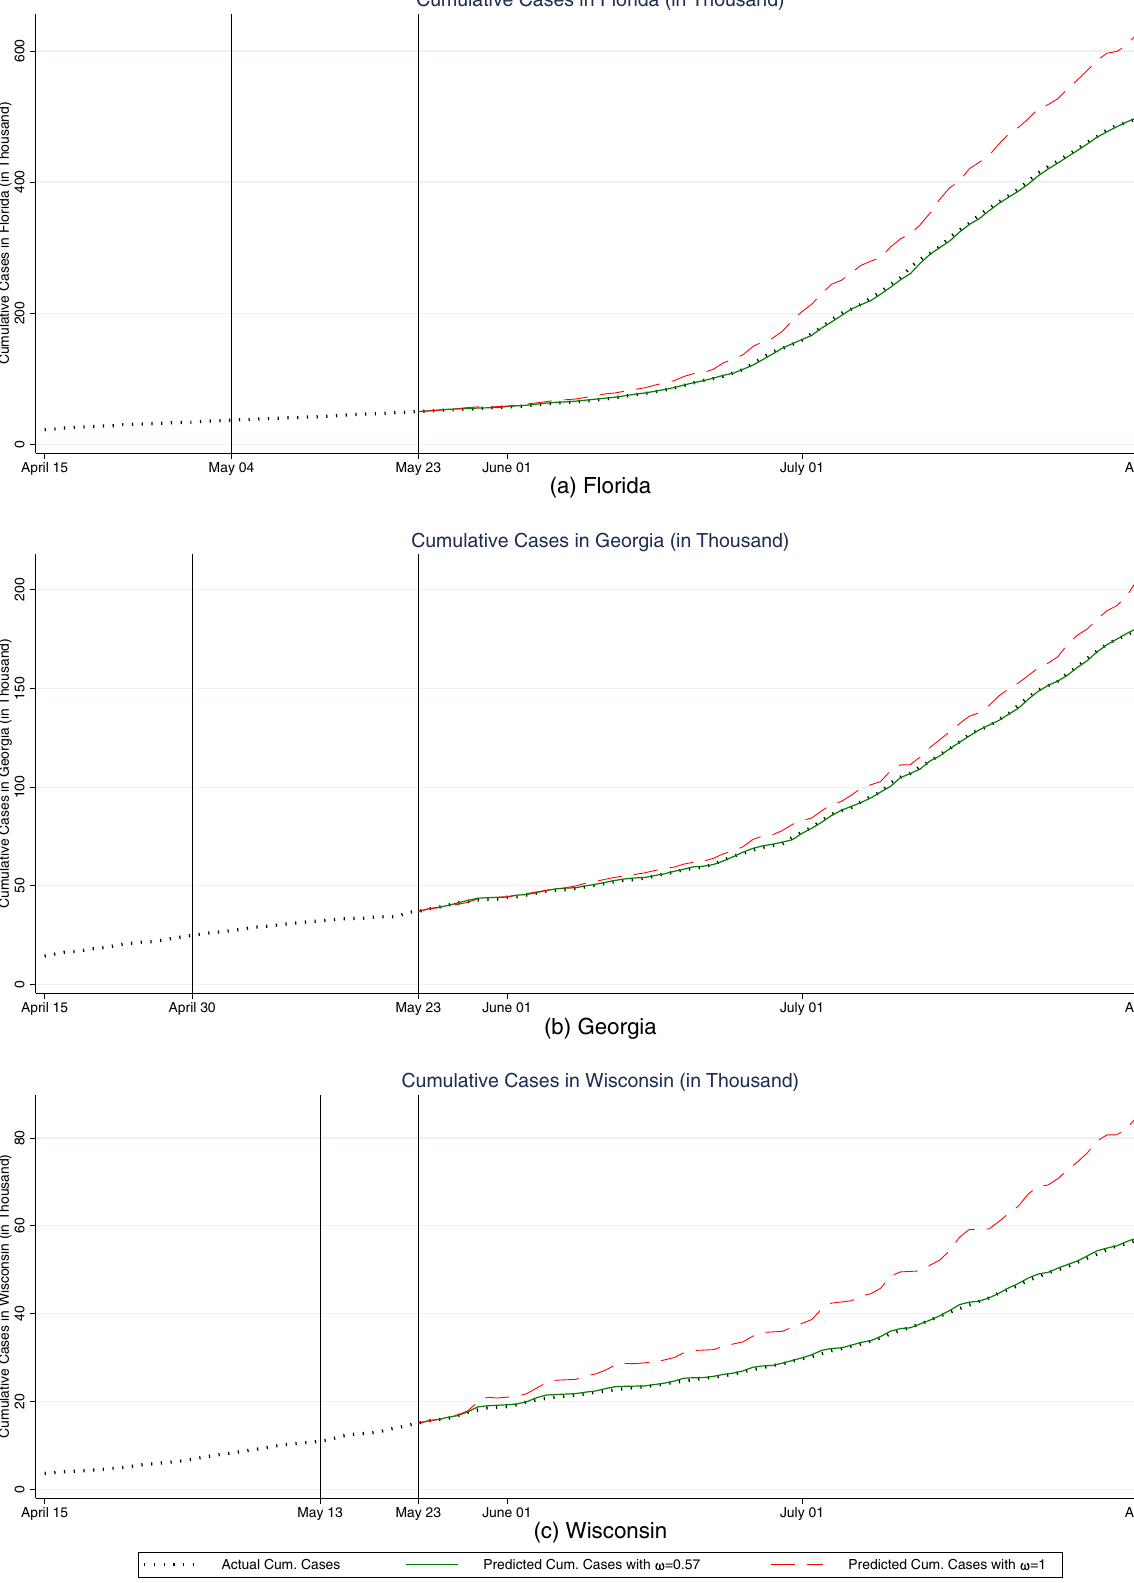
Figure 2. Out-of-sample fit comparisons of Florida, Georgia, and Wisconsin between our model and the standard SIR model. The vertical line on May 23, 2020 indicates the last date used to estimate each model. The vertical lines to the left indicate the expiration date of Shelter-in-Place order in each